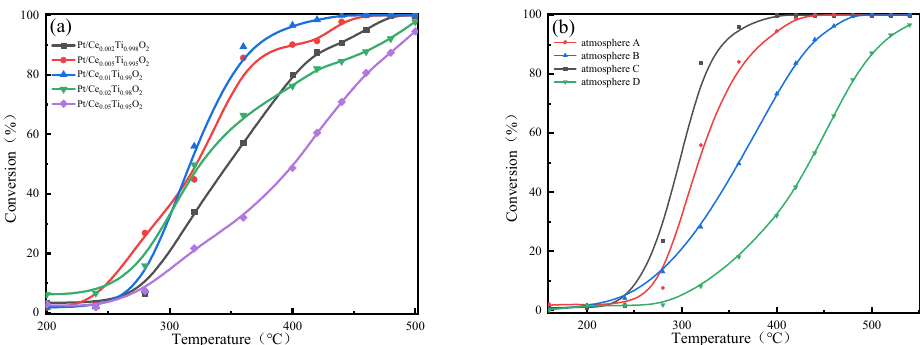
Figure 2. ( a ) Catalytic activity of Pt/Ce x Ti 1 − x O 2 catalysts. Reaction conditions: [C 2 H 6 ] = 1000 ppm, [O 2 ] = 4 vol%, [H 2 O] = 5%, [SO 2 ] = 100 ppm, balance N 2 , total flow rate = 200 mL/min, and GHSV = 60,000 h − 1 . ( b ) Catalytic activity of Pt/Ce 0.01 Ti 0.99 O 2 catalysts in different atmospheres. Atmosphere A: 1000 ppm ethane, 4% oxygen, N 2 balance, 100 ppm SO 2 , and 5% water. Atmosphere B: 1000 ppm ethane, 4% oxygen, and N 2 balance. Atmosphere C: 1000 ppm ethane, 4% oxygen, N 2 balance, and 100 ppm SO 2 . Atmosphere D: 1000 ppm ethane, 4% oxygen, N 2 balance, and 5% water.